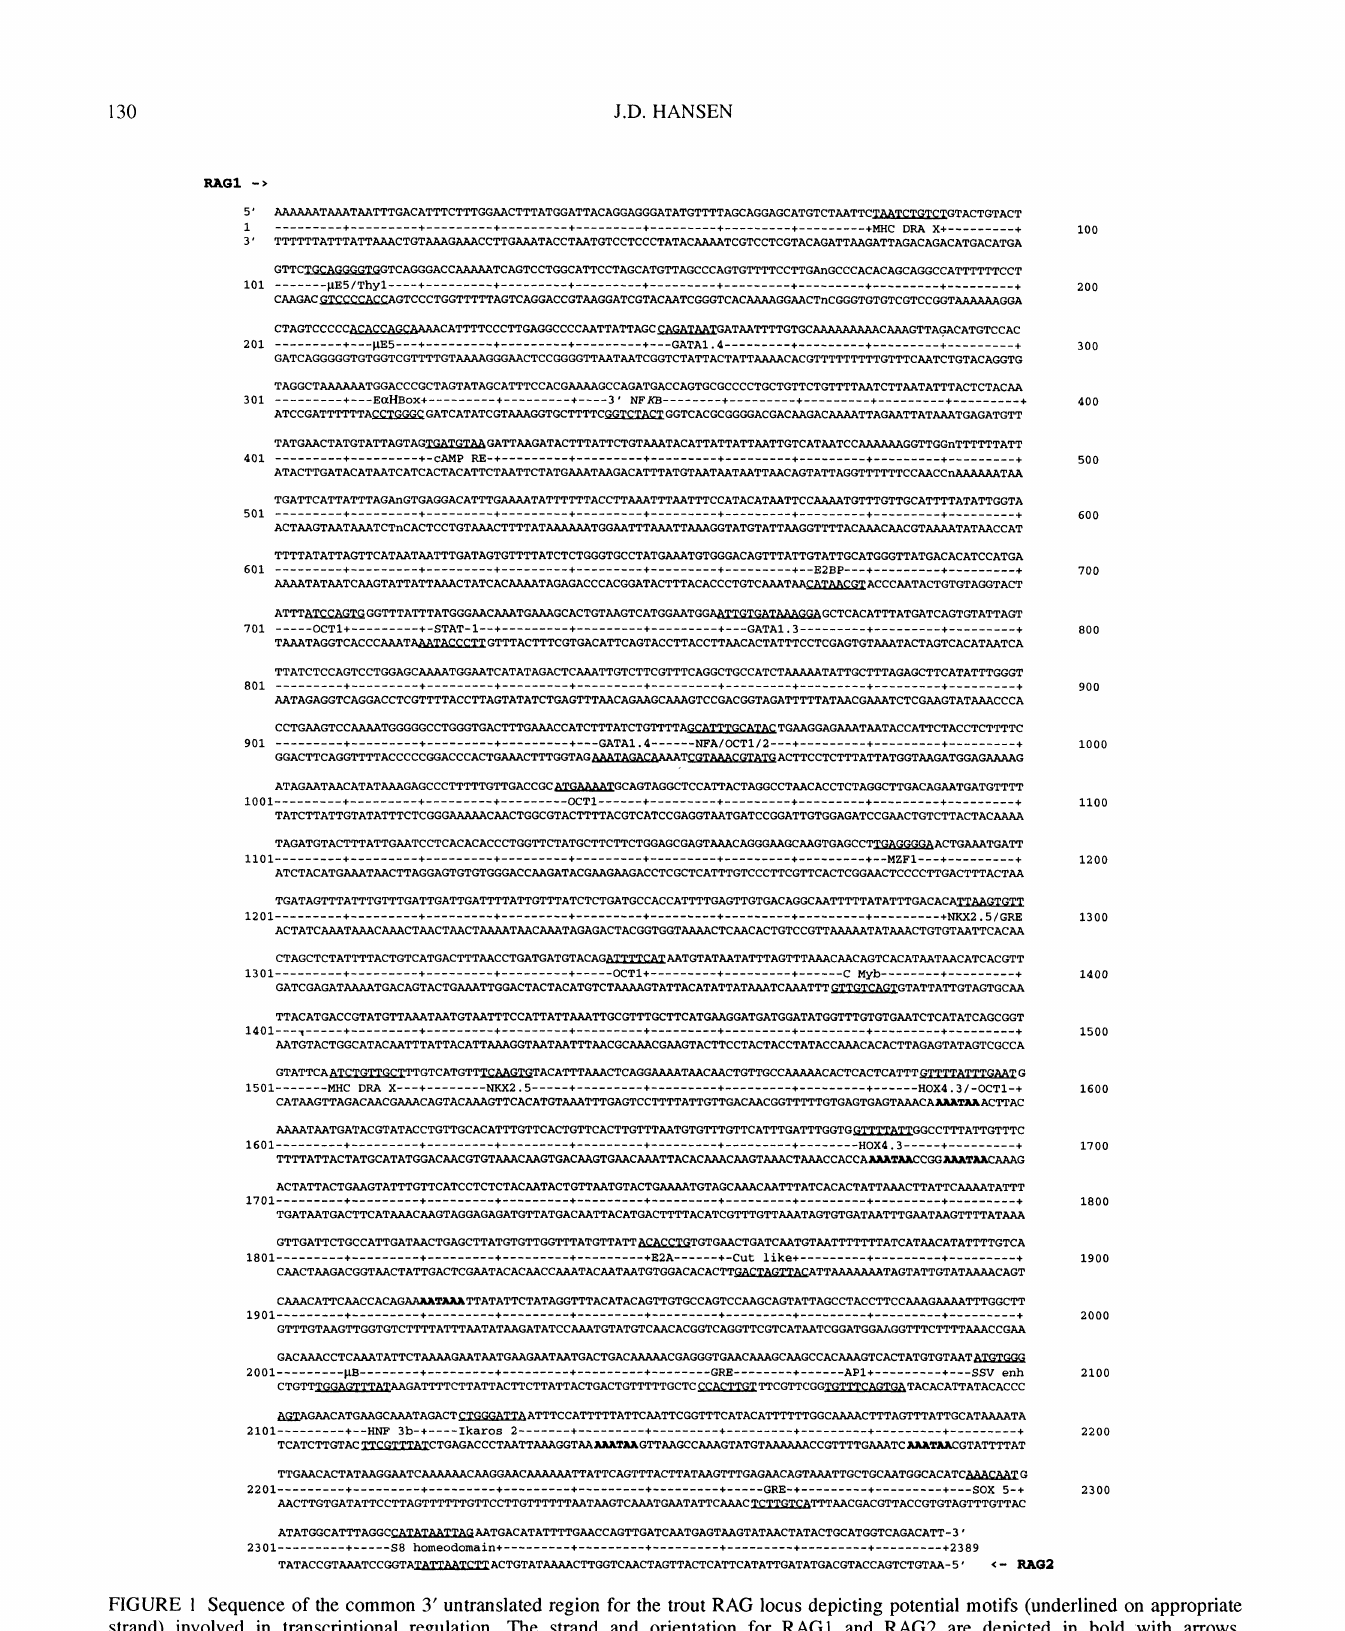
FIGURE Sequence of the common 3’ untranslated region for the trout RAG locus depicting potential motifs (underlined on appropriate strand) involved in transcriptional regulation. The strand and orientation for RAG1 and RAG2 are depicted in bold with arrows. Polyadenylation sites are in bold (Hansen and Kaattari,